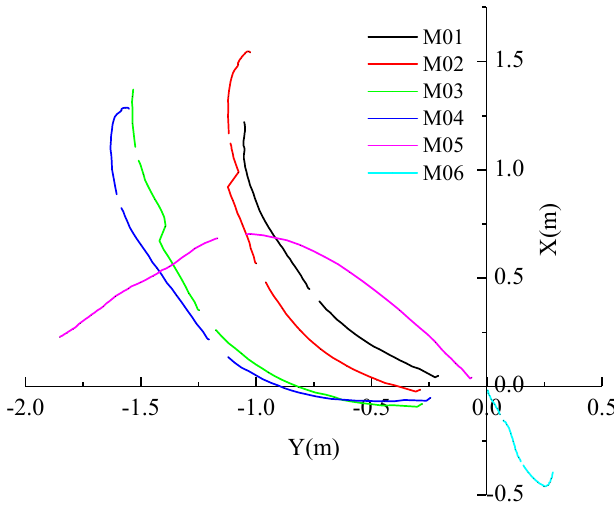
Figure 8. The track of the horizontal movement of the monitoring points.